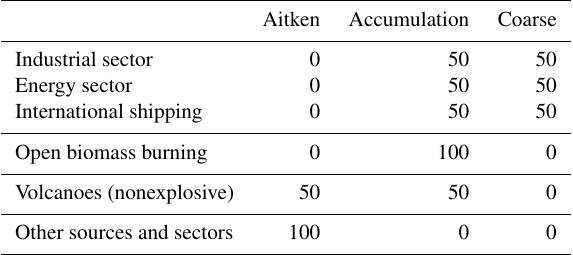
Table 5. Distribution of the sulfate emissions from the various sources and sectors over the soluble Aitken, accumulation, and coarse modes, as mass